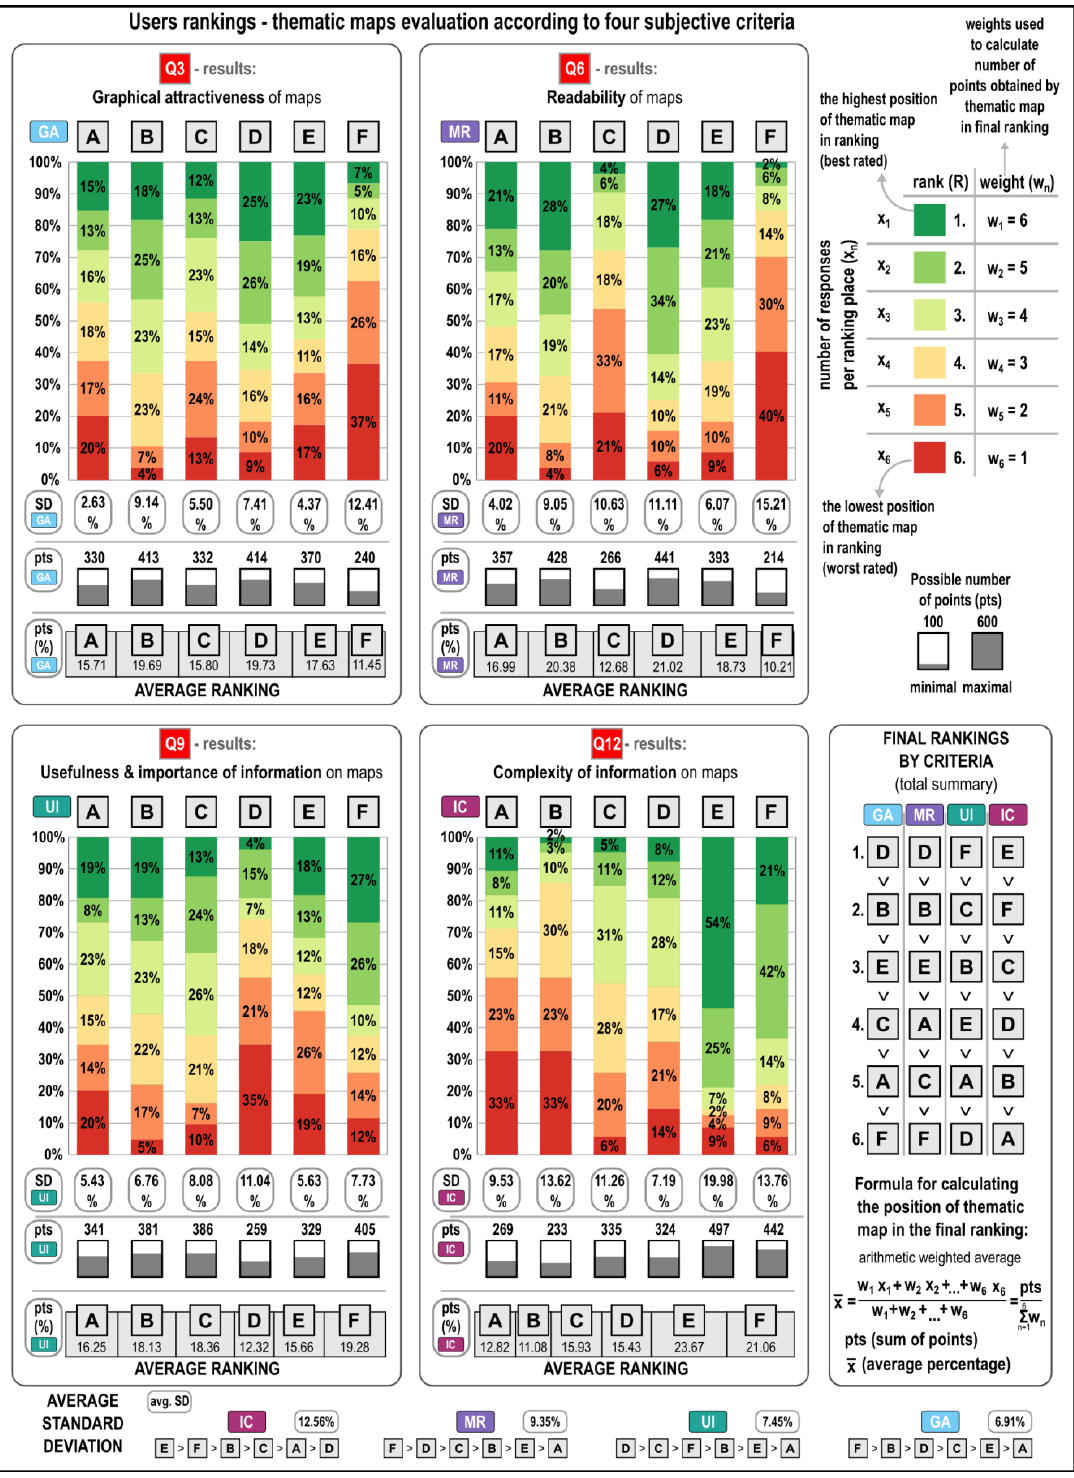
Figure 4. Results for the rankings of thematic maps created by individual participants of the study according to the subjective evaluation criteria and the final rankings created, taking into account all positions in particular rankings and assigned weights according to the formula provided.